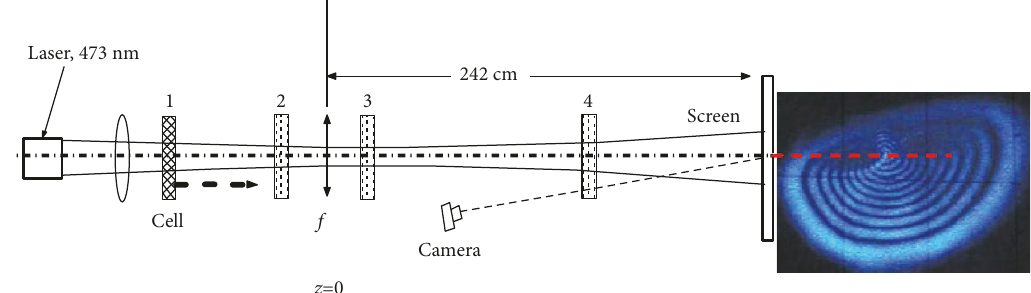
Figure 1: The scheme of the experiment and the profile of the laser beam trace on the screen.